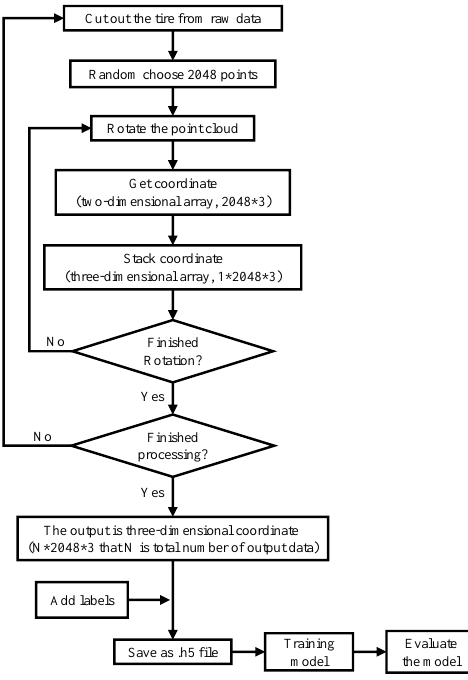
Figure 3. Data augmentation flow chart.